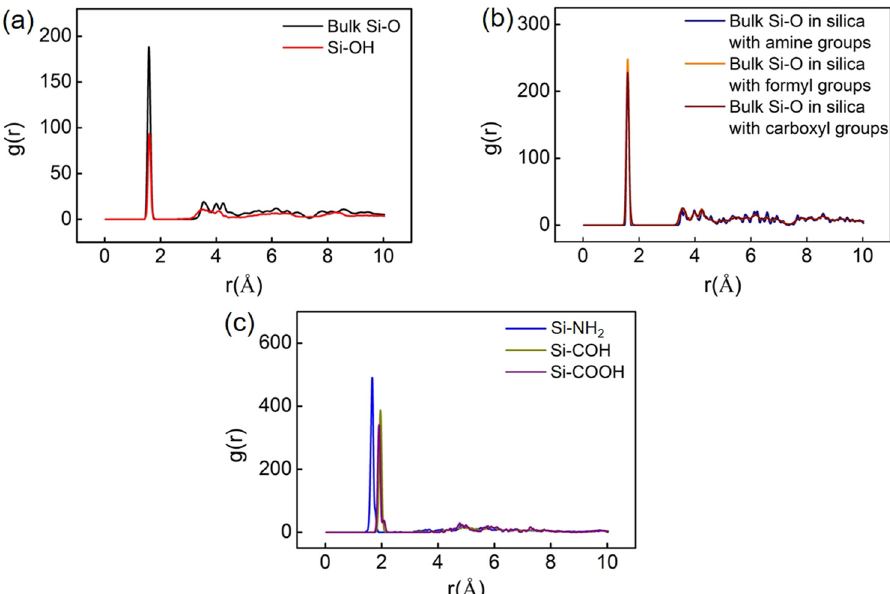
Figure 4: ( a ) The partial RDF of Si – O bond in silica model with the surface covered by hydroxyl groups. The length of the Si – O bond in silanol group ( Si – OH ) and in silicon oxygen tetrahedron ( referring to bulk Si – O ) is 1.58 Å, close to that measured by experiments. ( b ) The partial RDF of bulk Si – O bond in di ff erent silica models where the length of Si – O bond is close. ( c ) The partial RDF of Si – N and Si – C bonds in silica models with the surface covered by formyl, carboxyl, and amine groups. The length of the Si – N bond is about 1.68 Å. The length of the Si – C bond in silica with formyl and carboxyl groups are 1.98 Å and 1.93 Å, respectively, close to that measured by